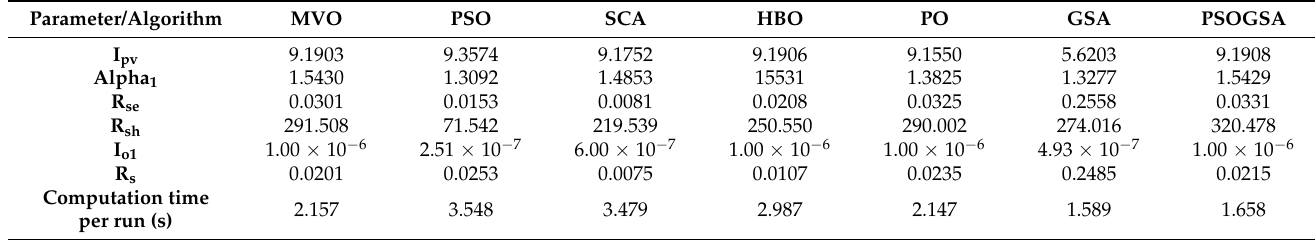
Table 4. The monocrystalline MSDM parameter estimation results.